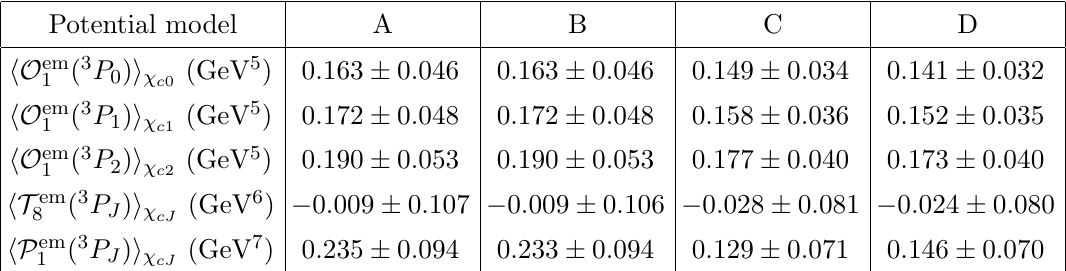
Table 5 . The LDMEs h (cid:31) cJ (1 P ) jO em T em ( 3 P J ) j (cid:31) cJ (1 P ) i ( hT em 8